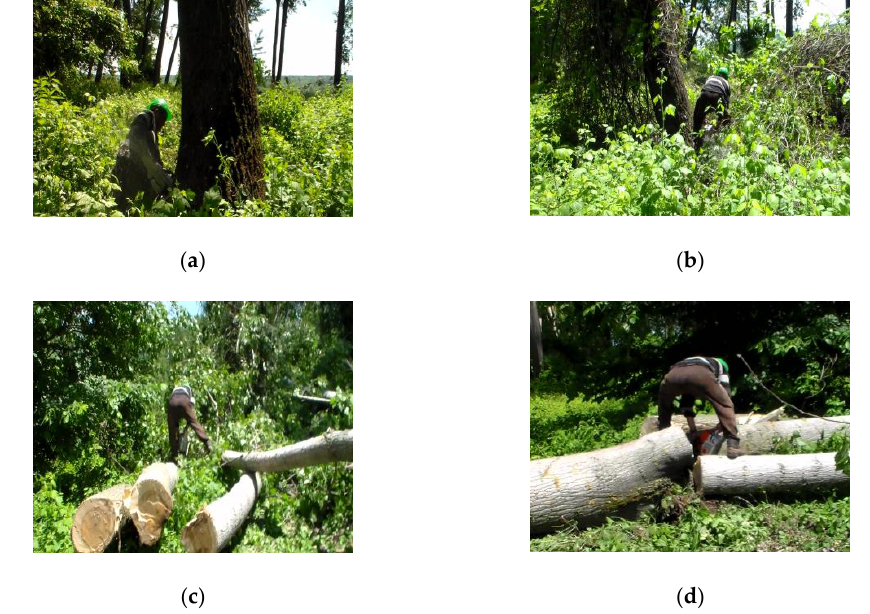
Figure 4. Awkward postures typical of motor-manual tree felling and processing: ( a ) Making the notch; ( b ) Making the felling cut; ( c ) Debranching; ( d ) Bucking.